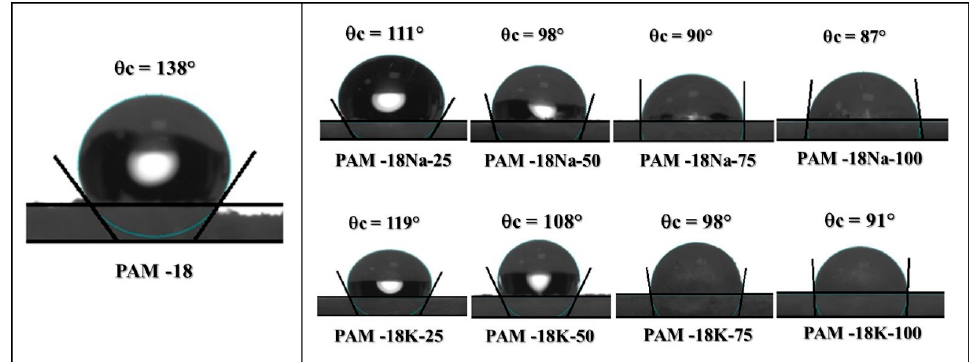
Figure 8. Contact angle variation between ultra-pure water and polymer derived from PAM-18 with different ionization degrees.